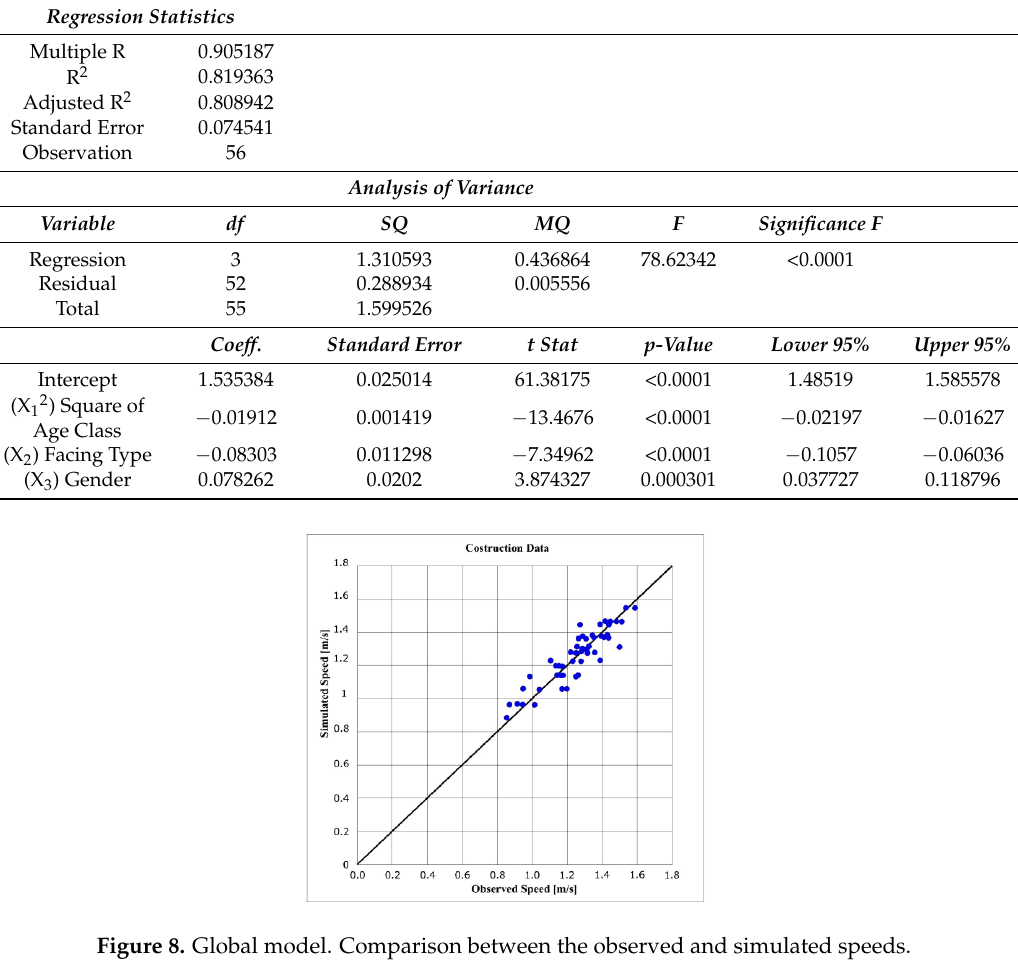
( b ) Figure 9. Comparison between observed and estimated dataset: construction phase ( a ); validation phase ( b ).